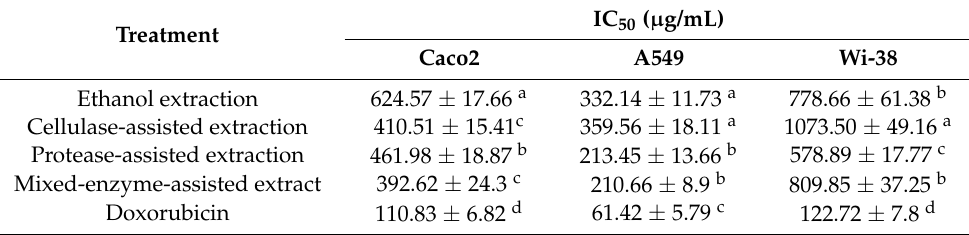
Table 4. Cytotoxic effects of corn tassel extracts by different extraction methods against Caco2, A549, and Wi-38 cell